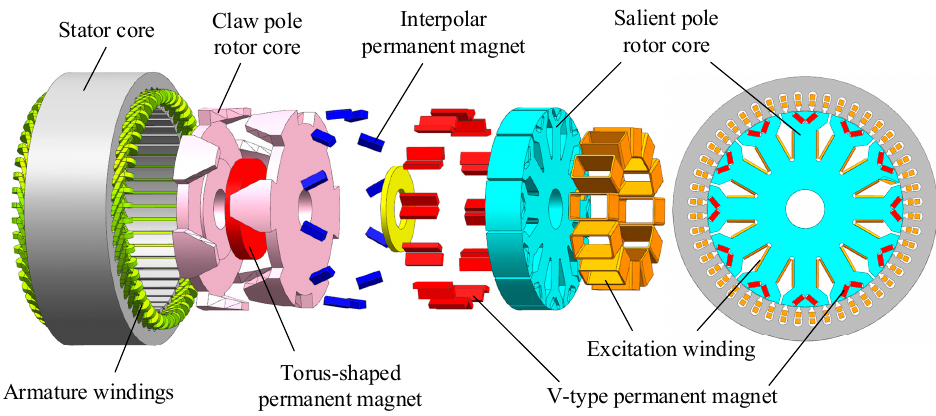
Figure 1. The structure of the new compound excitation generator.